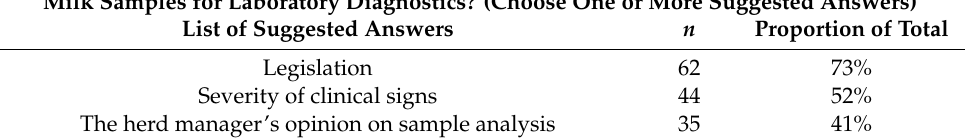
Table 2. Number ( n ) and proportion (%) of respondents who marked the suggested factors identified when making decisions about collecting milk samples in cases of clinical mastitis. Based on answers from 85 Danish